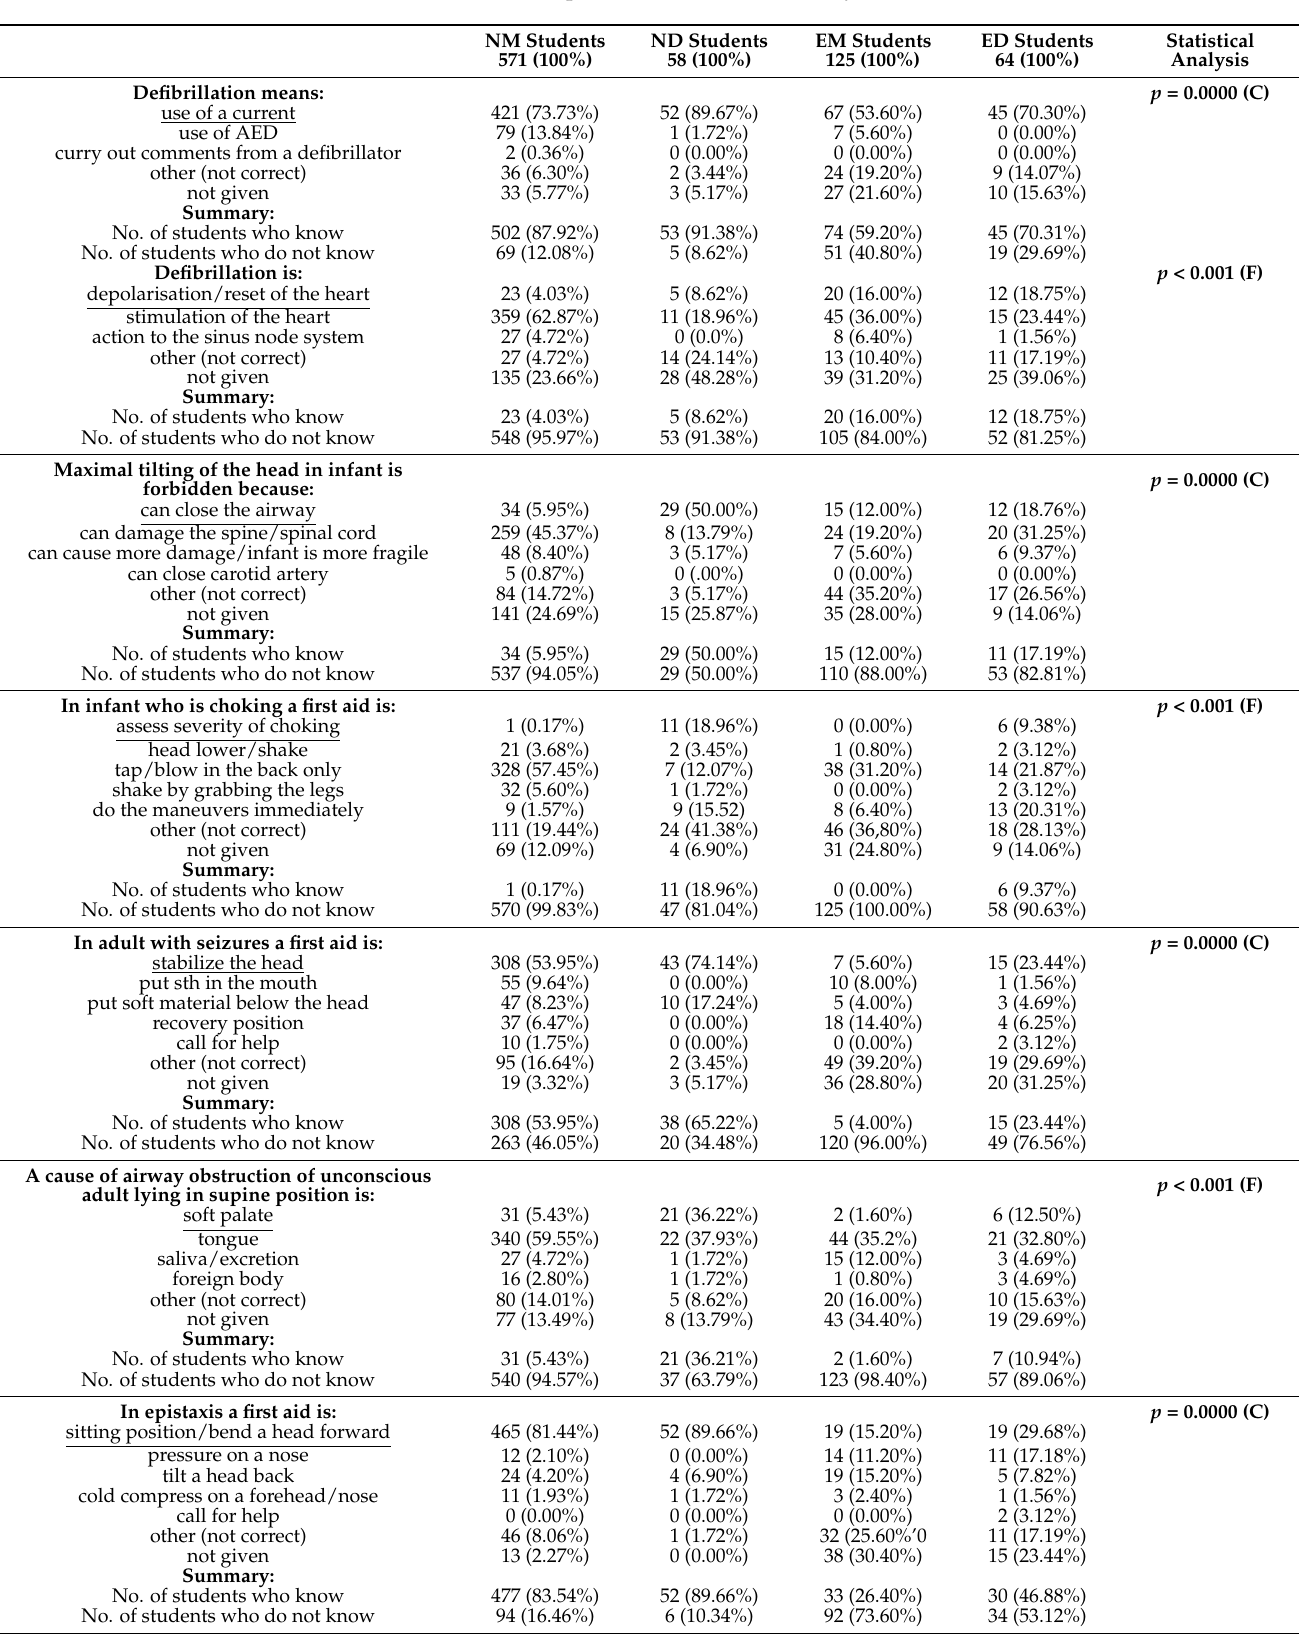
Table 2. Answers to the questions and statistical